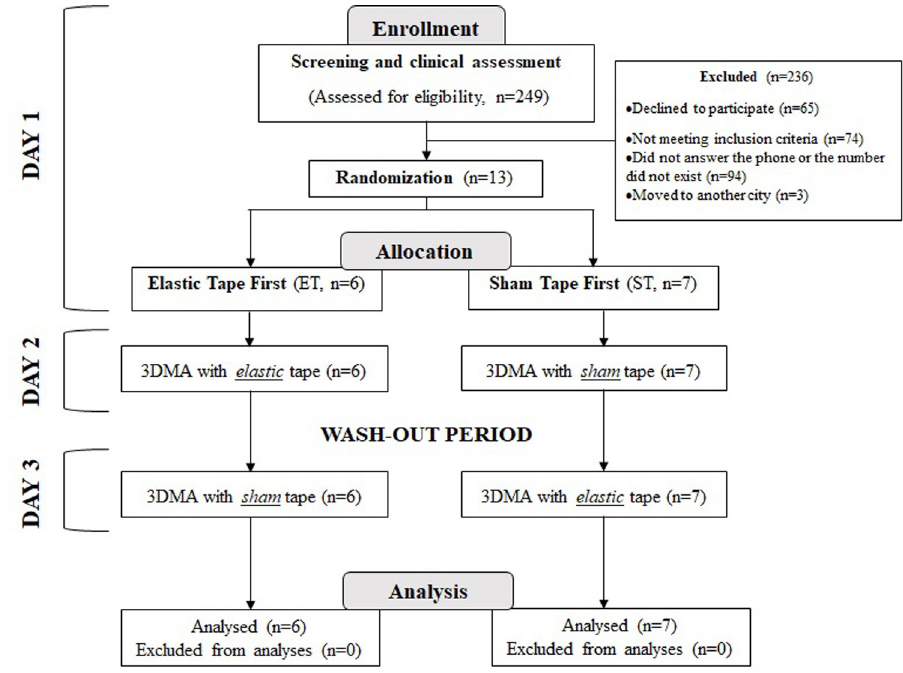
Fig 1. Schematic representation of the experimental design and